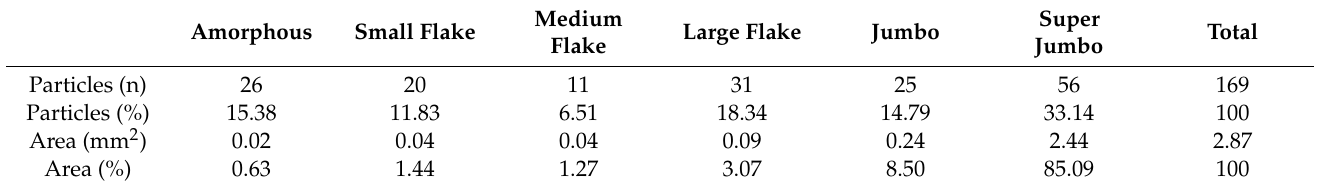
Table 7. Physical properties of graphite as determined by OM in a polished section.